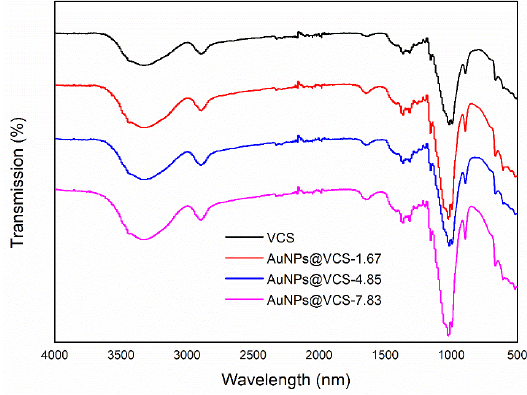
Figure 4. FTIR spectra for VCS and AuNPs@VCS.